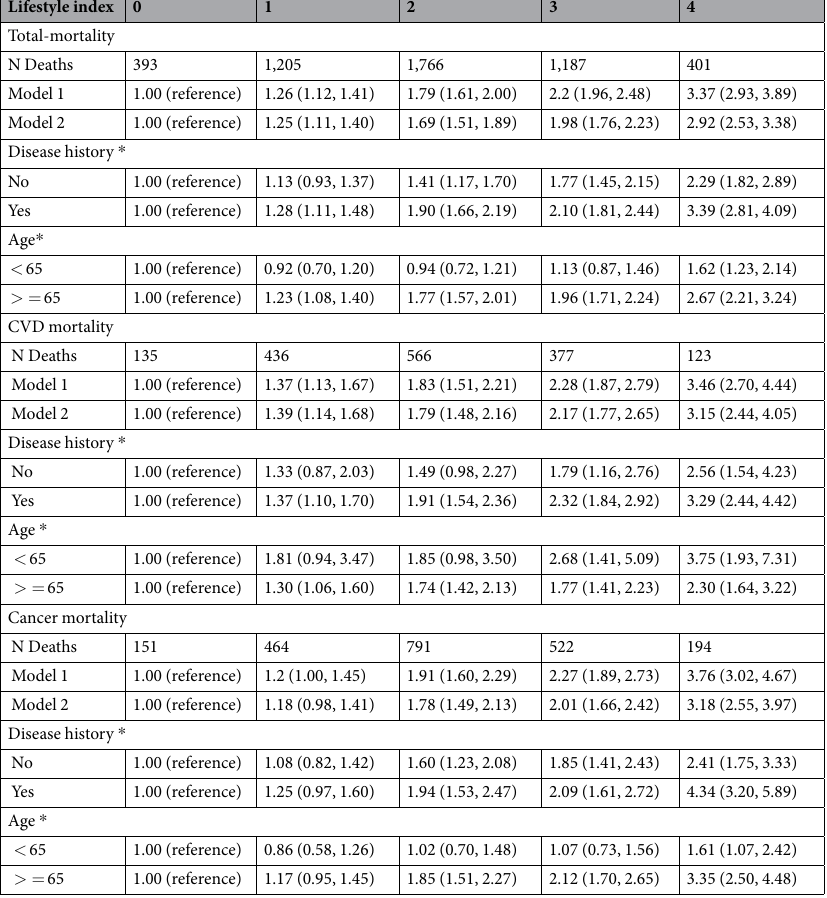
Table 4. Hazard ratios for all-cause, cardiovascular, and cancer mortality associated to lifestyle risk index,the Shanghai Men’s Health Study (2002–2013, n = 59,747). N: number; Disease history: Self-reported hypertension, diabetes mellitus, coronary heart disease, and stroke. Model 1: Adjusted for age group; Model 2: Adjusted for age group, education, income per person, occupation, history of hypertension, diabetes mellitus, coronary heart disease, and stroke; All P values for trend < 0.001; * Model 2 was used to calculate the hazard